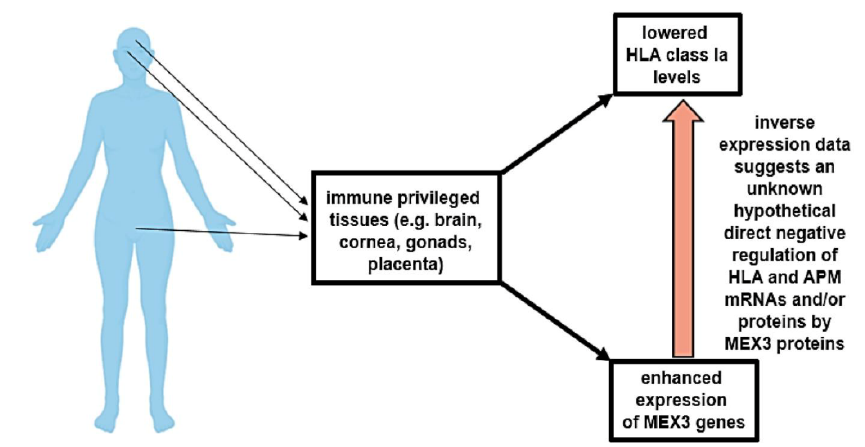
Figure 4. Postulated role of MEX-3 genes in the regulation of HLA class I expression.